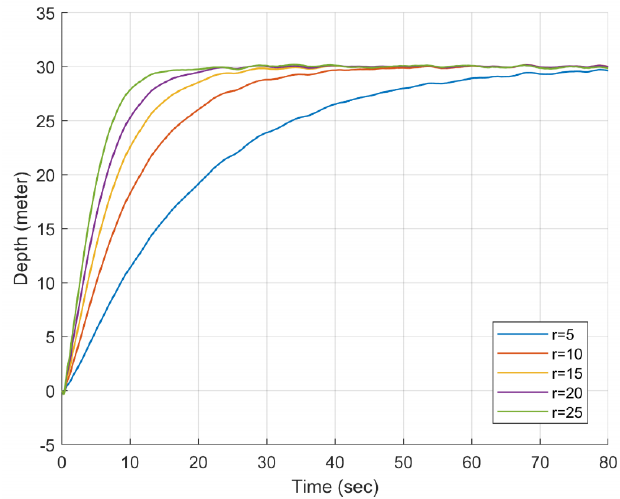
Figure 8. Variation of depth at different scale factors.